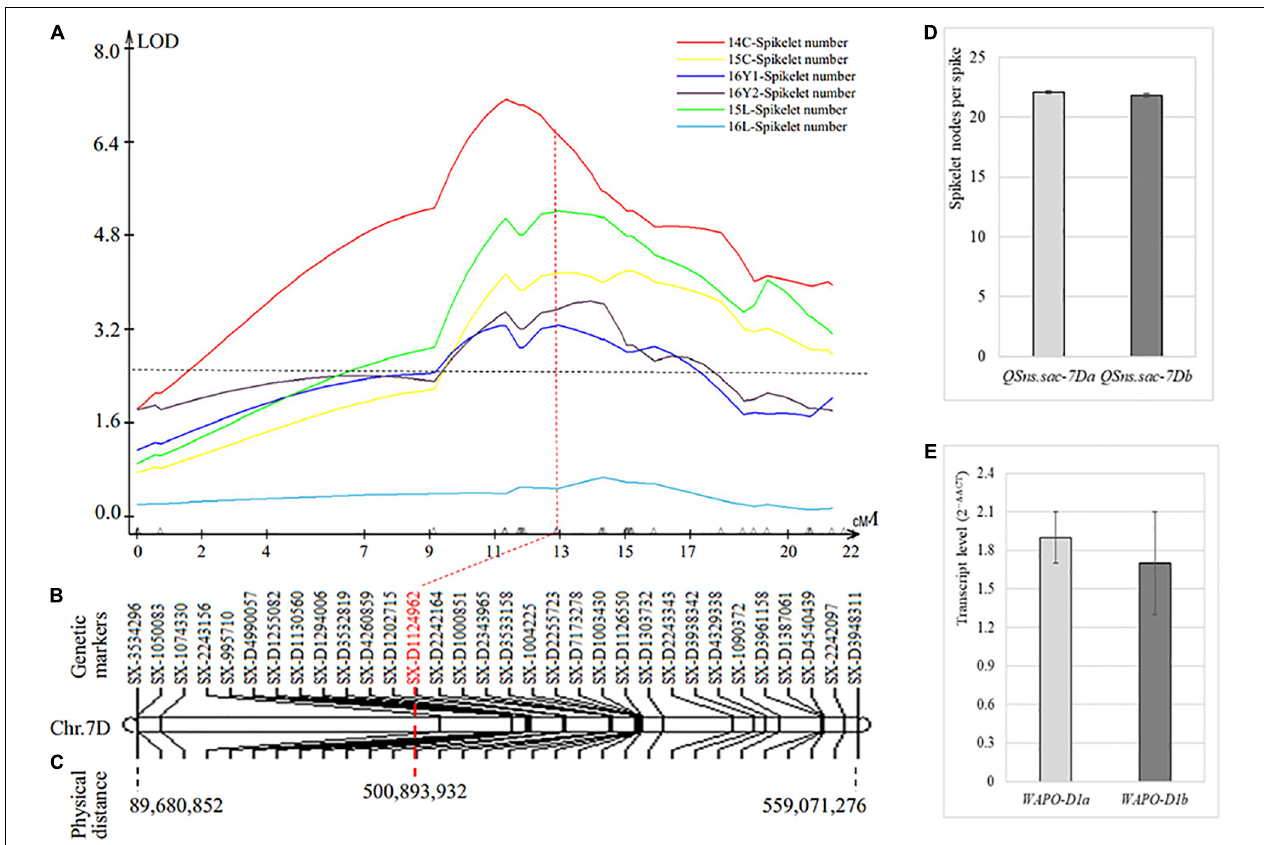
FIGURE 4 | Genetic and physical maps of SNS QTL QSns.sxau-7D . (A) Mapping of the QSns.sxau-7D locus. The phenotypic data was collected in Chengdu in 2014 (14C) and 2015 (15C), two experimental locations in Yuncheng in 2016 (16Y1 and 16Y2), and Linfen in 2015 (15L) and 2016 (16L). LOD value is indicated on Y axis, and genetic distance (cM) is indicated on X axis. (B) Genetic map of QSns.sxau-7D . The SX plus 8-digit SNP codes are markers from SNP from 17K SNP chips, and the SX-D plus 8-digit SNP codes are markers from the 35K DArT chips. (C) Physical map of QSns.sxau-7D . The physical locations of markers are shown based on the Chinese Spring genome sequence of RefSeq v1.1. (D) Comparison of SNS between the SY95-71 QSns.sxau-7D allele and the CH7034 QSns.sxau-7D allele. (E) Comparison of WAPO-D1 transcript levels between the SY95-71 and the CH7034, without significant